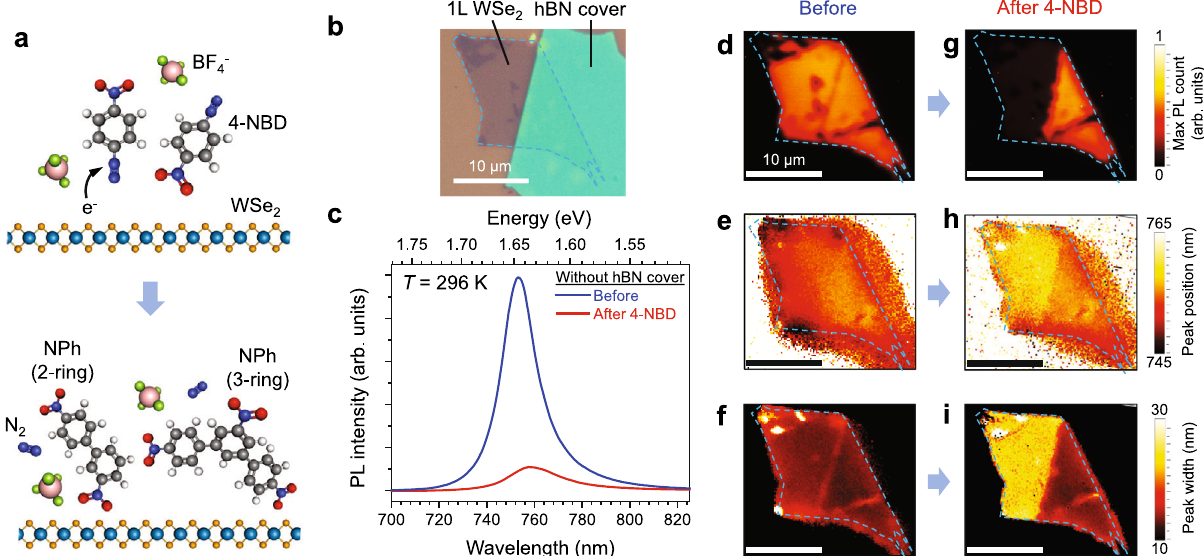
Fig. 1 | Room-temperature photoluminescence (PL) quenching following 4-nitrobenzenediazonium (4-NBD) treatment. a Illustration of the chemical functionalizationscheme. b Opticalimageofa1LWSe 2 thatispartiallycoveredwith a thinhBN fl ake. c Room-temperature( T =296K) PLspectra of1L WSe 2 beforeand after4-NBDtreatmentfromalocationwithoutthehBNcover,showingPLintensity quenching,redshifting,andbroadening.ThePLspectrumfromhBN-covered WSe 2 does not show signi fi cant changes before and after 4-NBD treatment